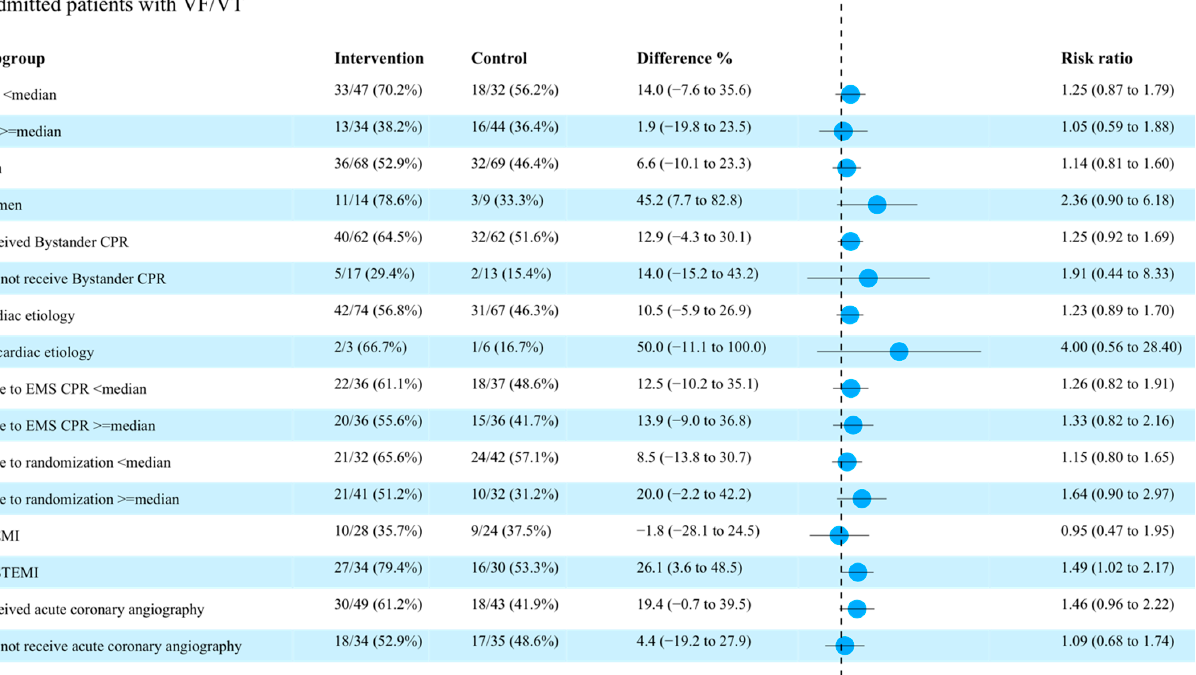
Figure 2. Forest plot in the subgroup of patients with an initial shockable rhythm. CPR = cardiopulmonary resuscitation; EMS = emergency medicine system; STEMI = ST-elevation myocardial infarction. The distribution of the CPC scores between groups, according to the initial rhythm, is shown in Figure 3.